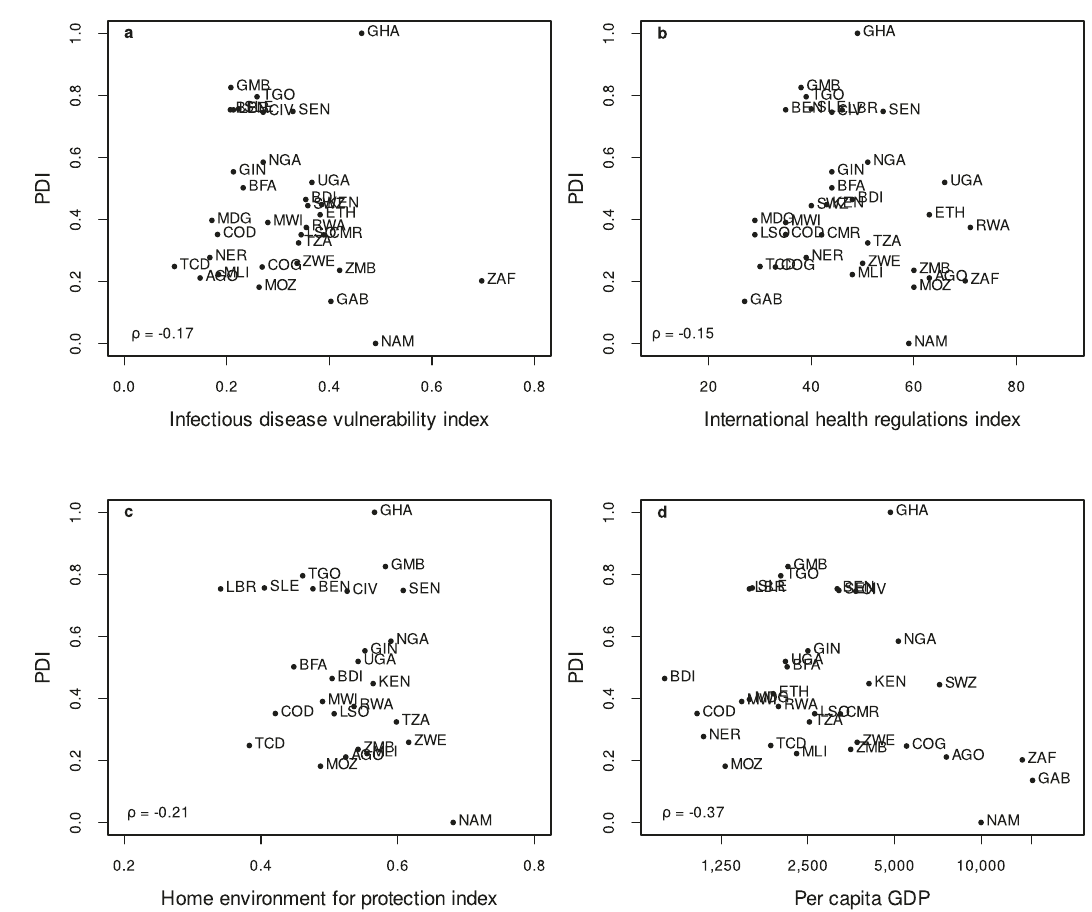
Fig. 5 Correlation of the PDI with related indices and GDP per capita. Scatter plot of the PDI (using the latest available Demographic Health Survey of a country) against the infectious disease vulnerability index ( a ) 26 ; the WHO international health regulations index ( b ) 25 ; the home environment for protection index ( c ) 29 ; and the country's GDP ( d ) 2 . Note that a high PDI implies a lack of essential private infrastructure, and hence, high risk of disease transmission; accordingly, countries in the top of boxes have a lack of private infrastructure, and hence, lack the capacity to limit disease transmission. Moreover, note that for the infectious disease vulnerability index, the WHO international health regulations index, and the home environment for protection index, a higher value indicates a better preparedness, or protection. In addition, ISO-3 country codes are used to abbreviate the countries in this fi gure. See Supplementary Table 2.1 for details on the ISO-3 country code. Source: DHS, Moore et al. 26 , Gilbert et al. 28 , and World Development Indicators 2 ; calculations by the